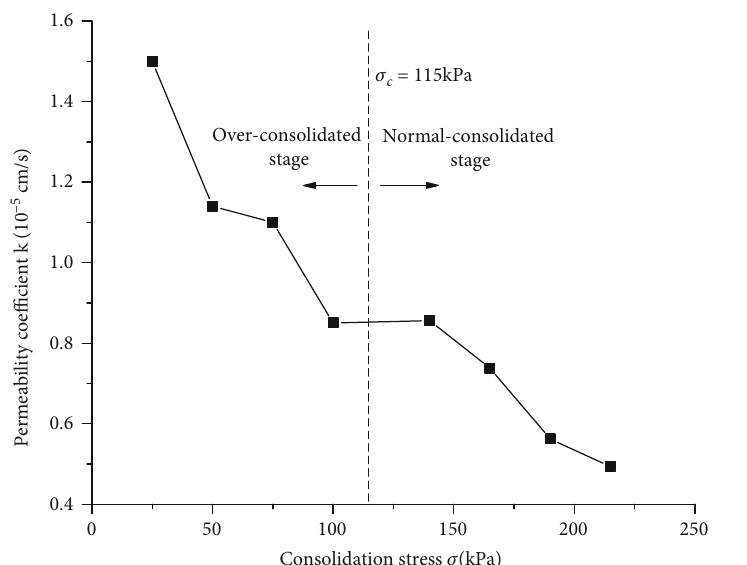
Figure 20: Variation curve of permeability coe ffi cient with consolidation pressure during one-dimensional consolidation of normally and overconsolidation saturated